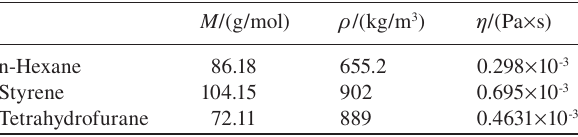
Table 1 Physical properties of the used